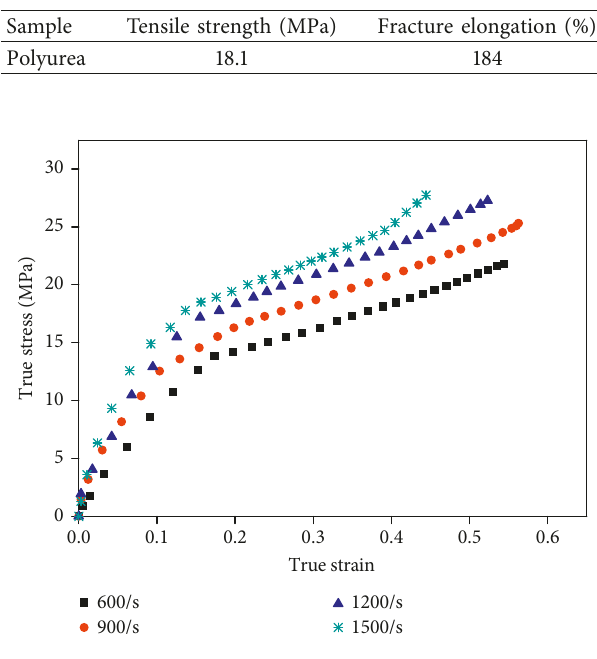
Figure 1: The true tensile stress-strain curves of polyurea under different strain